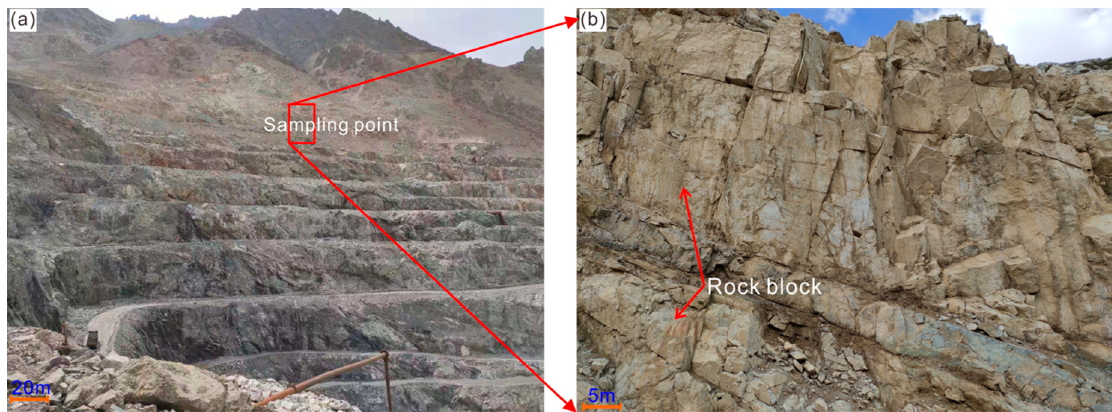
Figure 1. Area the rock samples were obtained from: the Beizhan open mine pit slope. ( a ) Photo of the western open pit slope; ( b ) rock mass structure at the sampling point.